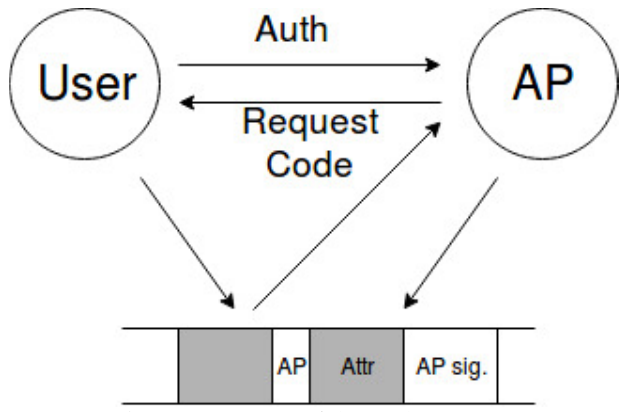
Figure 3. Authentication and flow of request